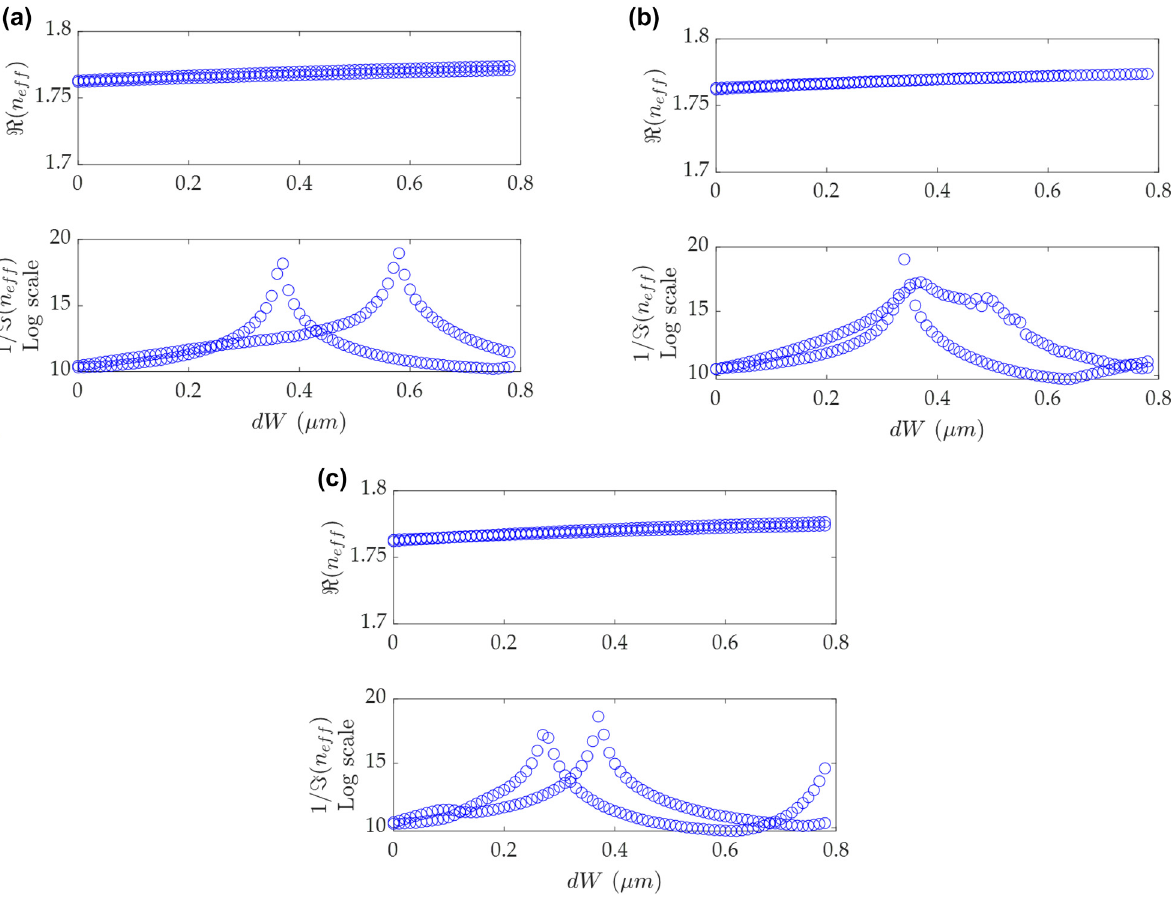
= 1.8 μ m, dis = 1.5 μ m, and 1 = W + d W and 1 1